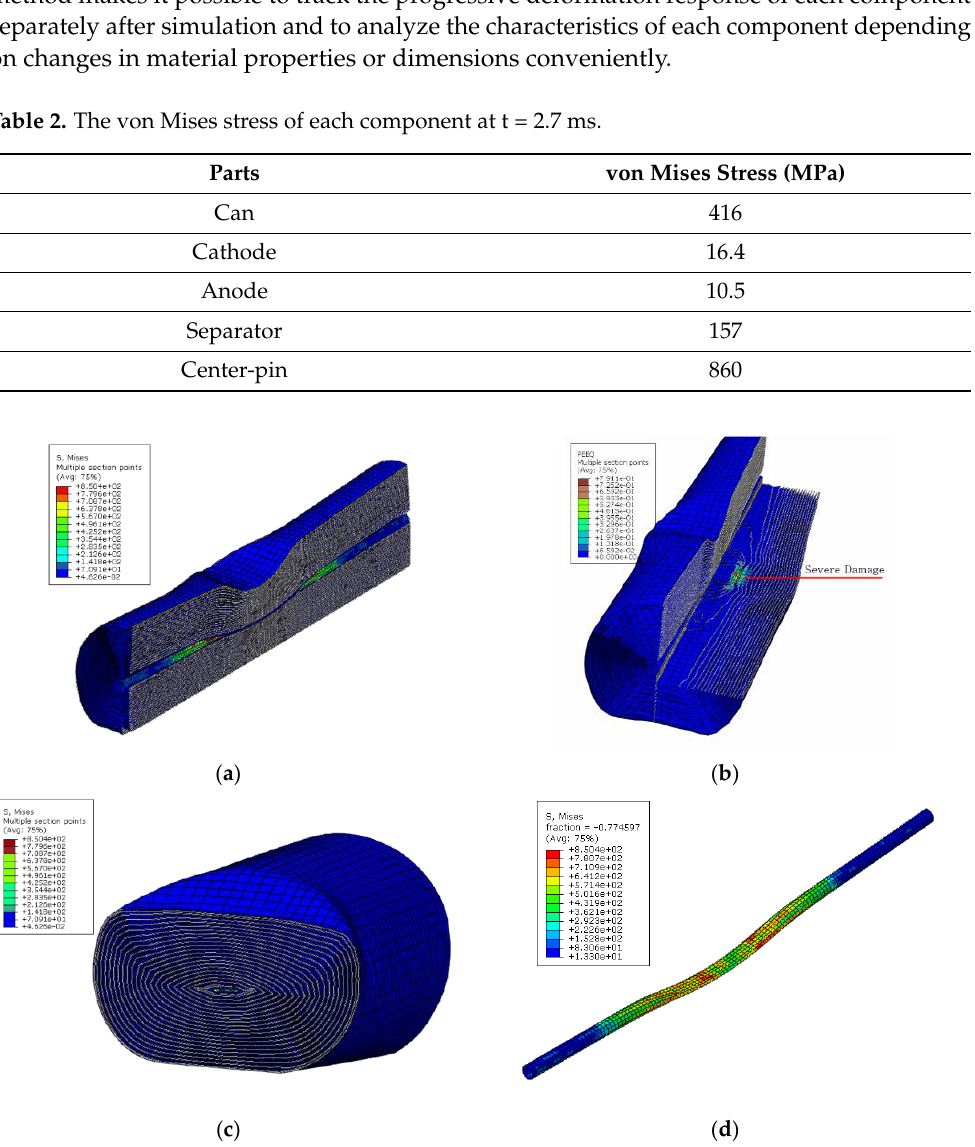
Figure 6. Plastic dissipation comparison plot in a roll of a separator for without, 0.1 and 0.3 mm- thick center-pin cases, respectively. 4. Discussion For cases with a center-pin, we compared the initial plastic energy dissipation within a few milliseconds, and a cell with a 0.3 mm thickness center-pin dissipates more plastic energy than a cell with a 0.1 mm thickness. Although the difference in plastic energy dis- sipation is subtle, it is possible that the cell with a 0.1 mm thickness center-pin might suffer from a thermal runaway. At the beginning of an internal short, the battery is still active, and the magnitude of the short area is heuristically considered to be a dominant factor for a thermal runaway. If the short area is large enough to discharge the stored energy within a short period, a thermal runaway will not occur. Otherwise, the battery might lead to a thermal runaway. At present, the criterion to distinguish these two different events is an